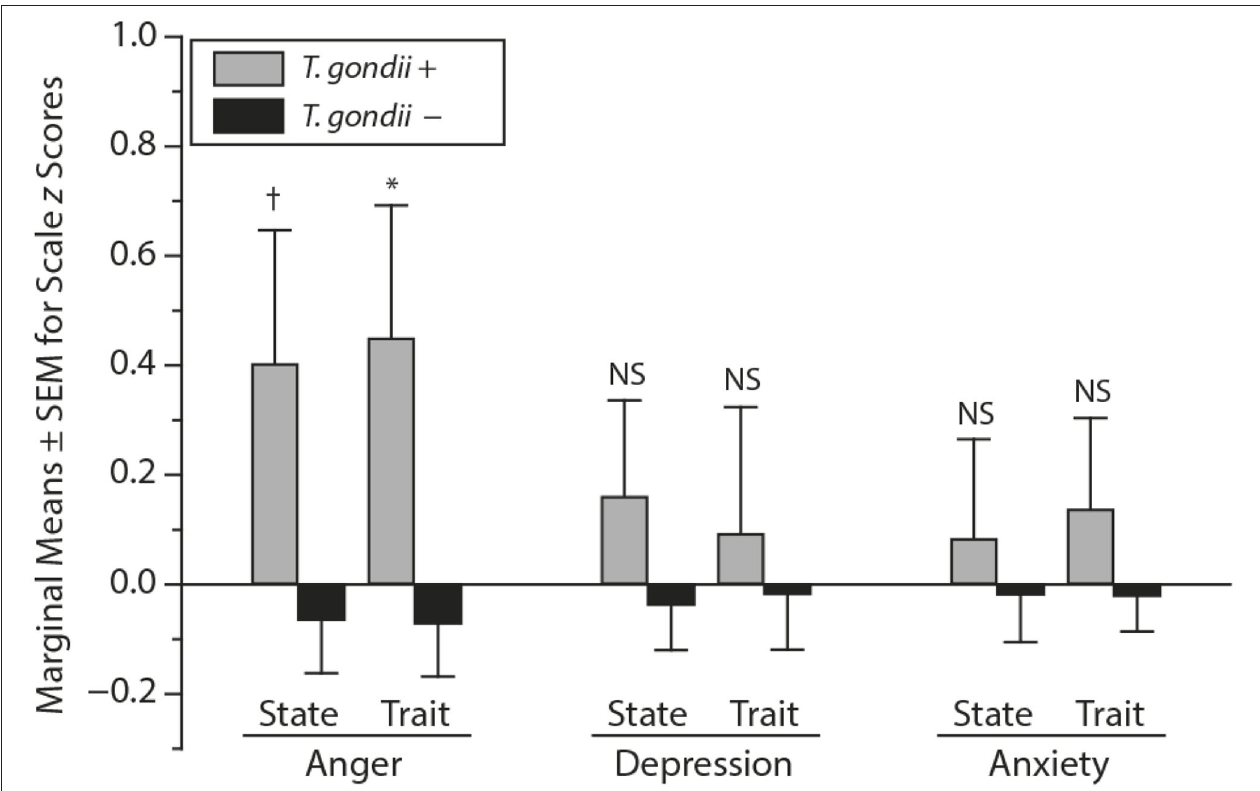
FIGURE 8 | State and Trait Anxiety, Anger, and Depression ( z ) scores (age as covariate) in T. gondii seronegative (–) and seropositive ( + ) participants. z scores were used to place all symptom measures on the same scale. NS, not significant; † p < 0.10; * p ≤ 0.05. While State and Trait Anxiety and Depression were not significantly different between T. gondii -positive and T. gondii -negative participants with Intermittent Explosive Disorder, the State and Trait Anger is significantly higher in T. gondii -positive participants relative to T. gondii -negative participants [Reprinted with permission from (117); Copyright 2016, Physicians Postgraduate Press. Reprinted by